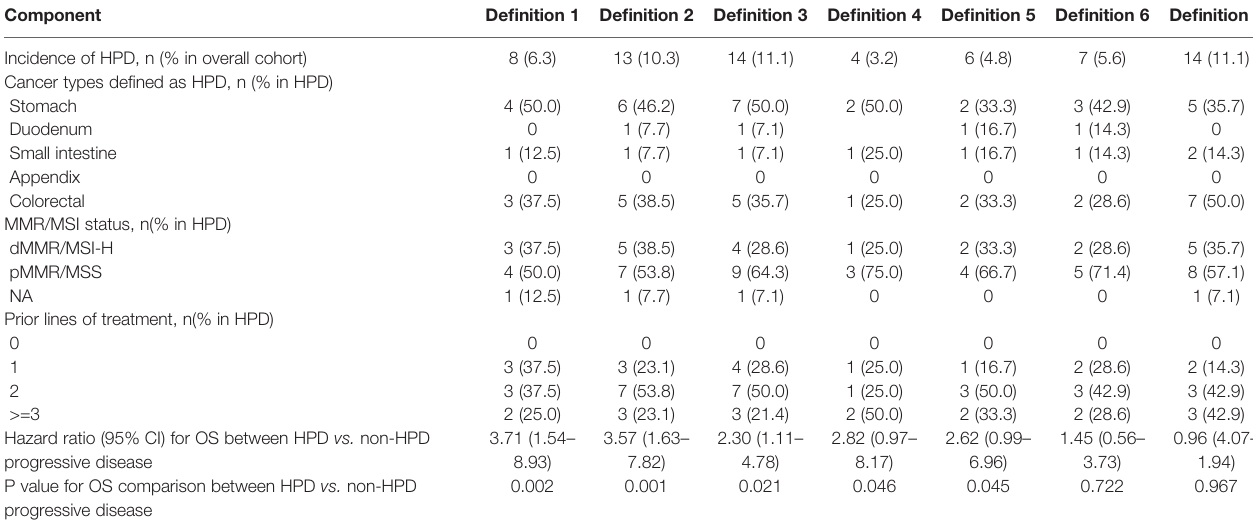
TABLE 3 | Characteristics of patients de fi ned as HPD according to different de fi nitions. Component